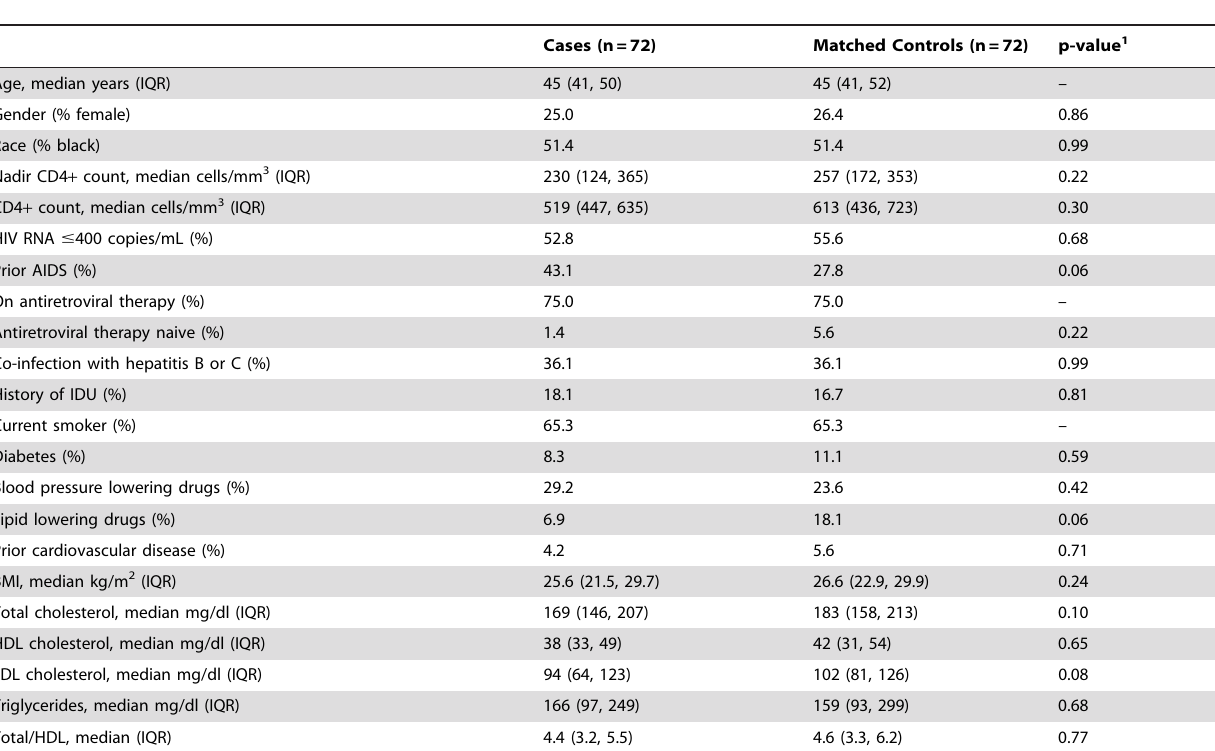
Table 1. Baseline characteristics for SMART trial participants with a bacterial pneumonia event (cases) and controls matched on age, smoking status, baseline antiretroviral therapy use, and clinical